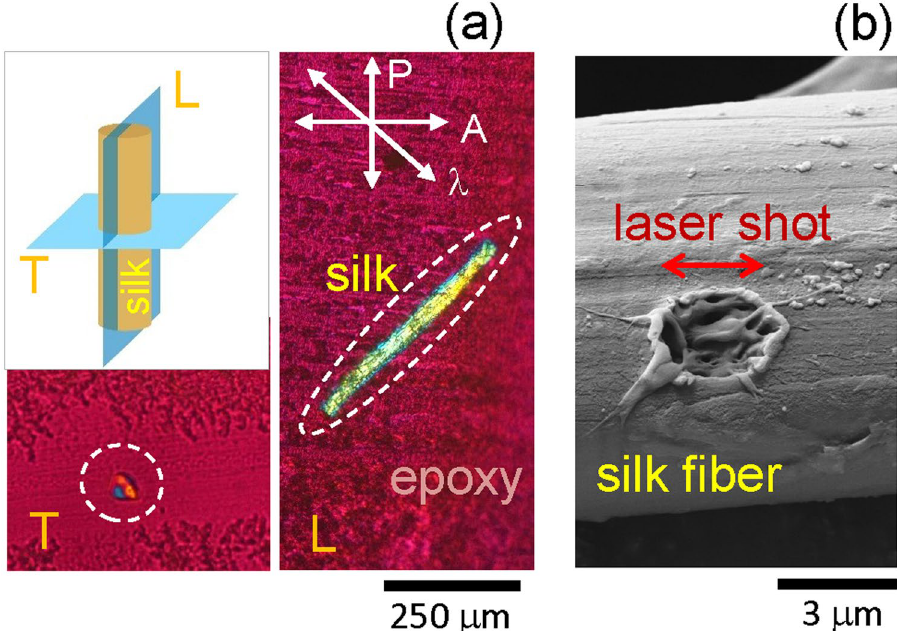
Figure 1. ( a ) Longitudinal (L) and transverse (T) 5–10 μ m-thin slices of silk embedded in epoxy were used for FT-IR micro-spectroscopic characterisation. Cross-polarised optical image of the sliced silk fiber obtained with a waveplate ( λ ) shifter. Sample preparation: silk fiber was aligned and epoxy embedded, microtome sliced for L and T directions. ( b ) SEM image of a single laser pulse melted silk; laser wavelength 515 nm, pulse duration 230 fs, focused with objective lens with numerical aperture NA = 0.5, pulse energy 85 nJ, linear polarisation was along the fiber (marked by